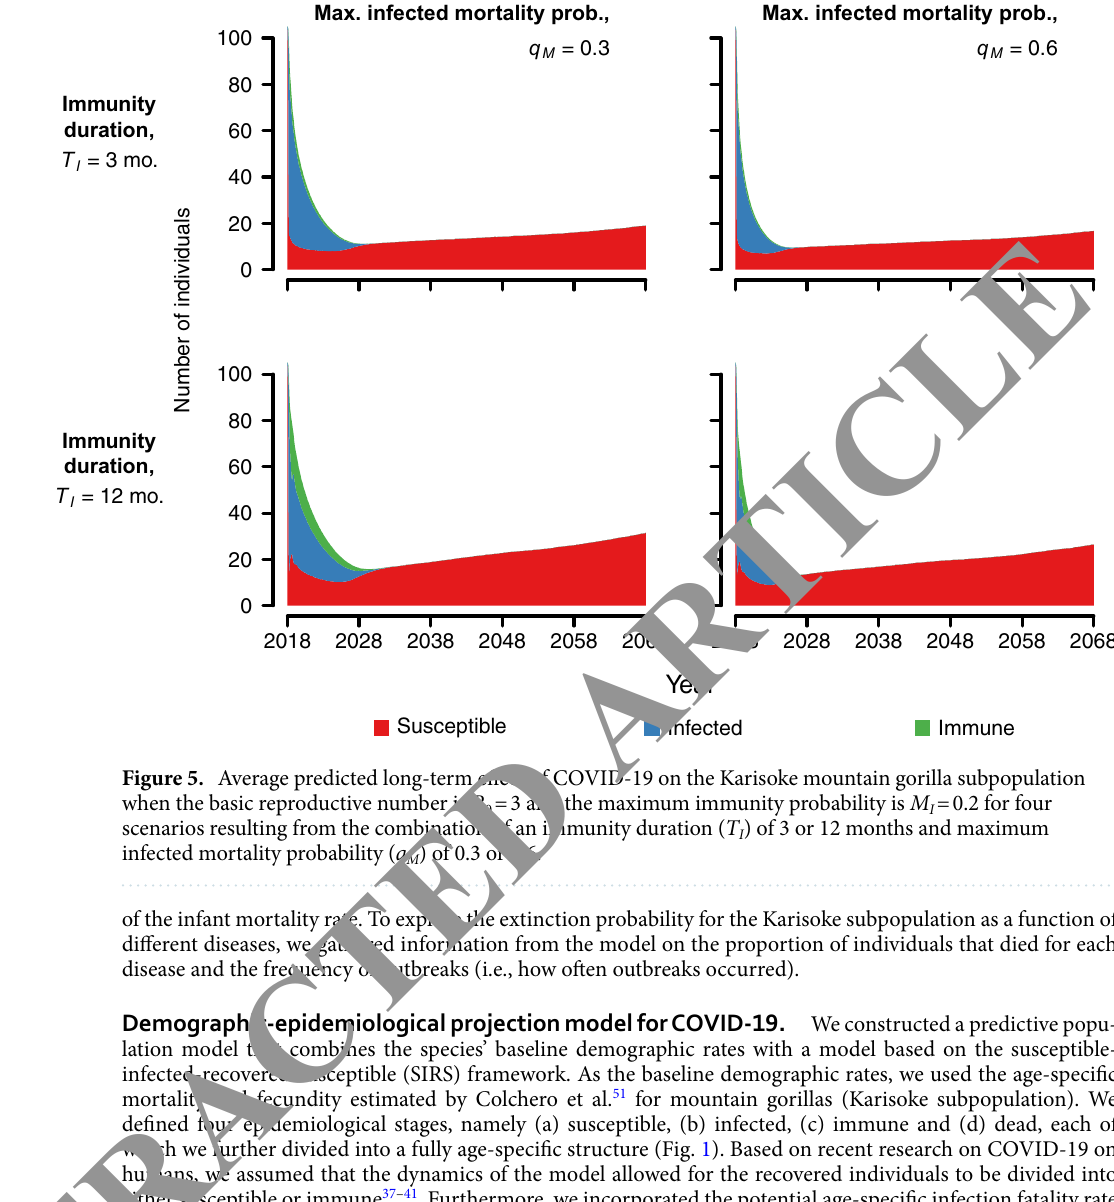
Figure 5. Average predicted long-term effect of COVID-19 on the Karisoke mountain gorilla subpopulation when the basic reproductive number is R 0 = 3 and the maximum immunity probability is M I = 0.2 for four scenarios resulting from the combination of an immunity duration ( T I ) of 3 or 12 months and maximum infected mortality probability ( q M ) of 0.3 or